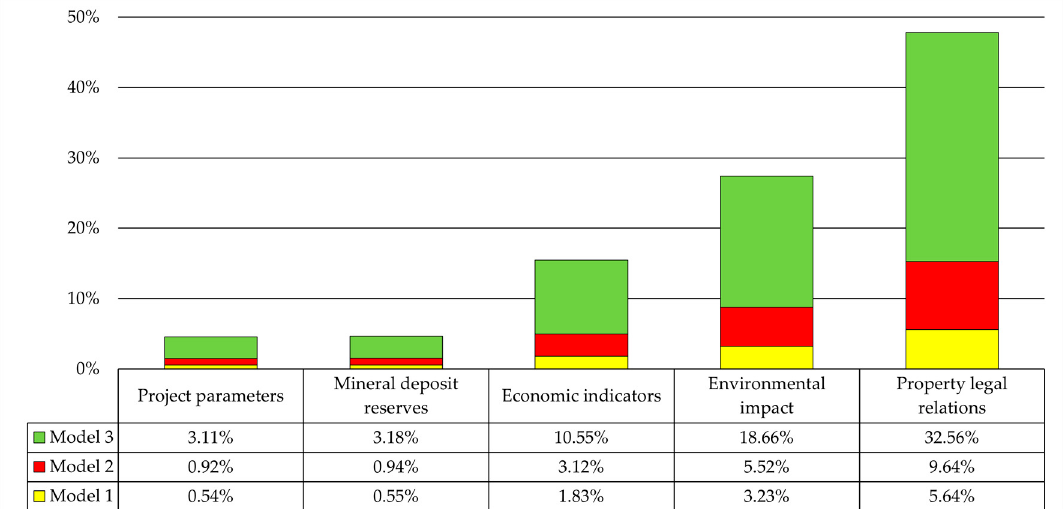
Figure 7. Cumulative display of the structure of the main groups of criteria for each model.